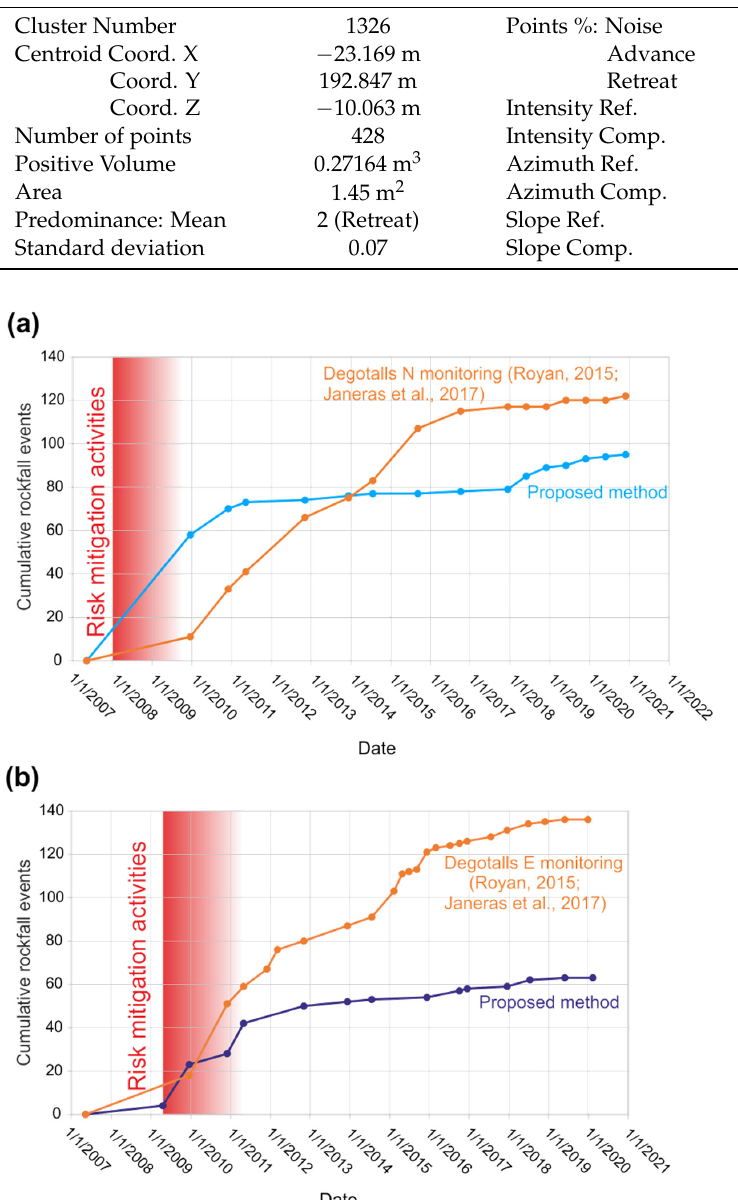
Figure 10. Rockfall events in ( a ) Degotalls N and ( b ) Degotalls E Orange lines represent the number of events registered with the methodology used to date with the standard methodology for monitoring point clouds [20,57]. Cyan and Purple lines represent the results of the proposed methodology in this study. Mitigation activities are marked from start to finish in red.